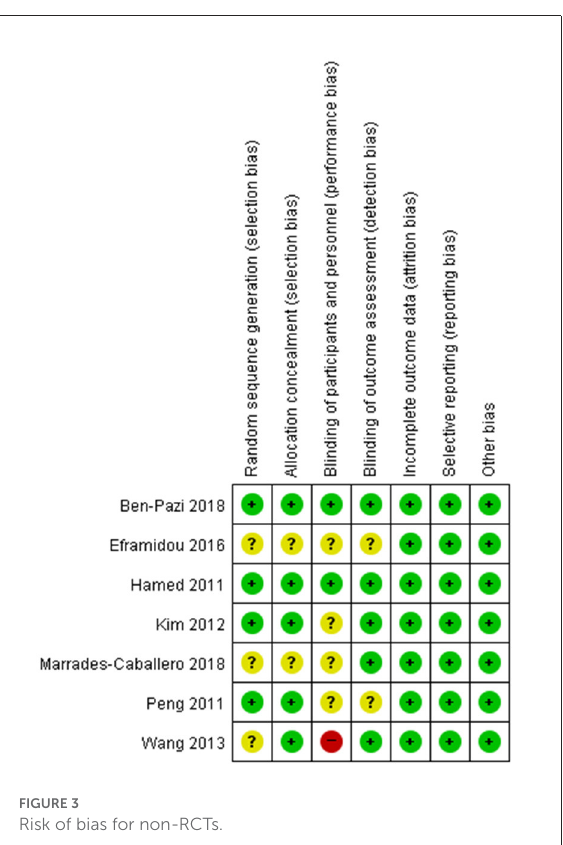
FIGURE3 Risk of bias for